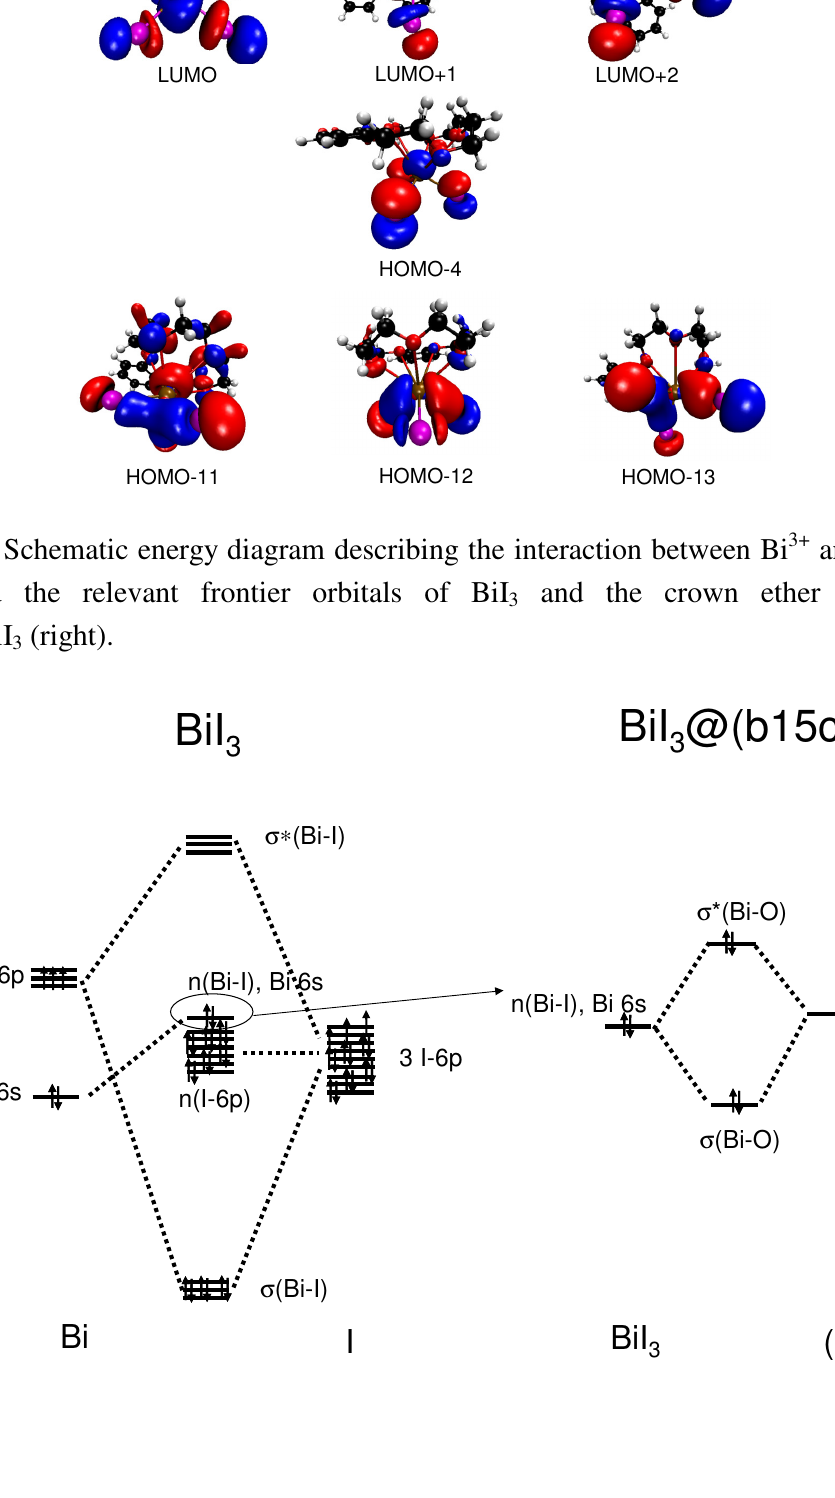
Figure 5. Selected graphical representations of frontier orbitals of (b15c5)BiI